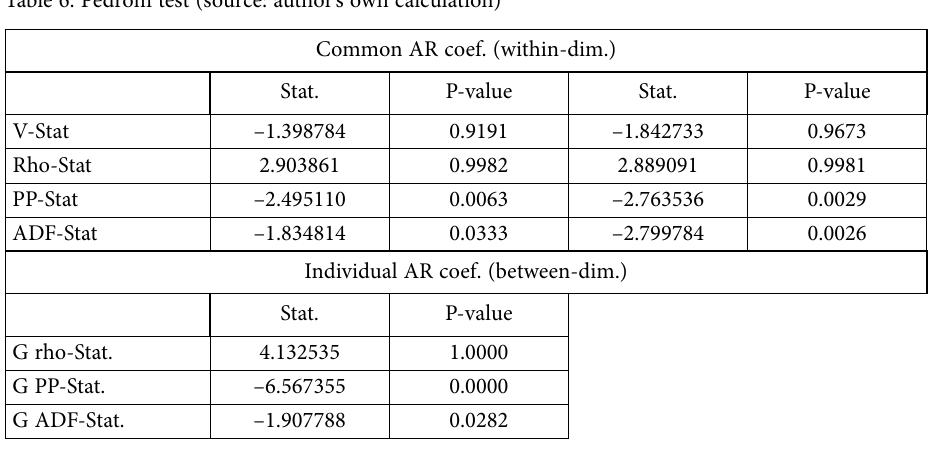
Table 7. Kao test (source: author’s own calculation) t-Stat. Prob. ADF –2.012845 0.0221 Resid. variance 0.000206 HAC variance 0.000161